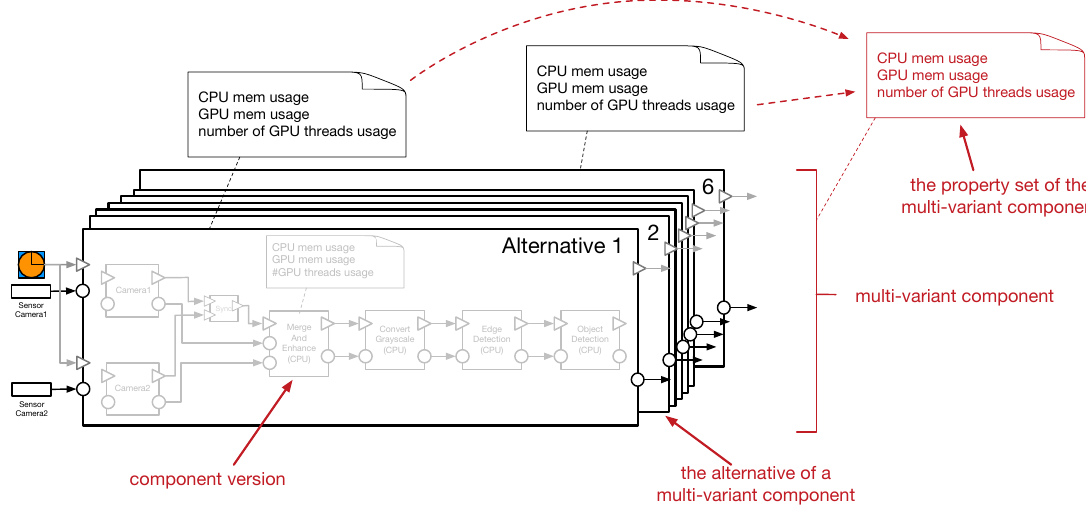
Figure 3. A multi-variant vision